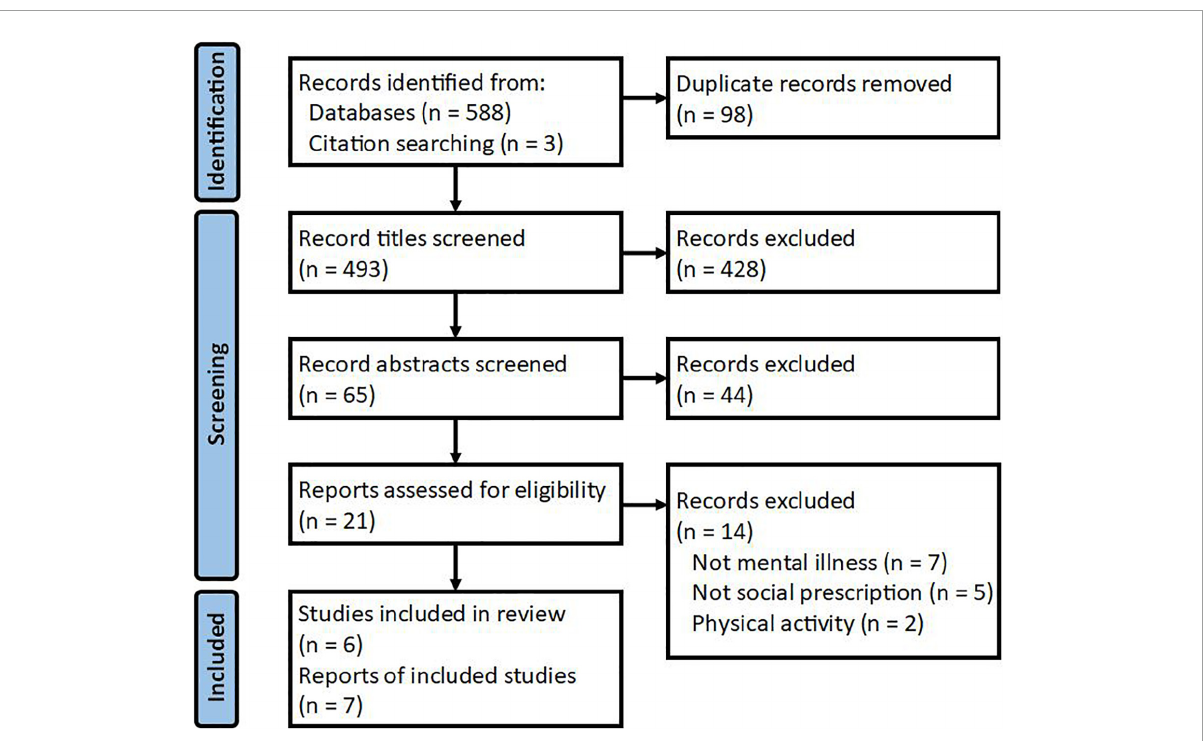
FIGURE1 Scoping review study selection PRISMA diagram. Adapted from Page et al.